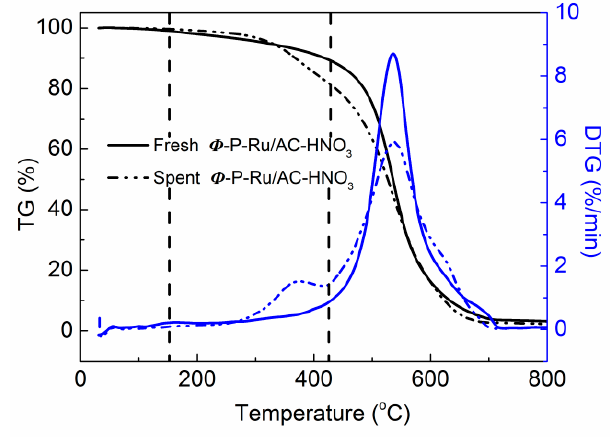
Figure 3. TG curves of the fresh and spent Ф - P-Ru/AC-HNO 3 catalysts. Table 2. The amount of coke deposition on the spent Ru-based catalysts.